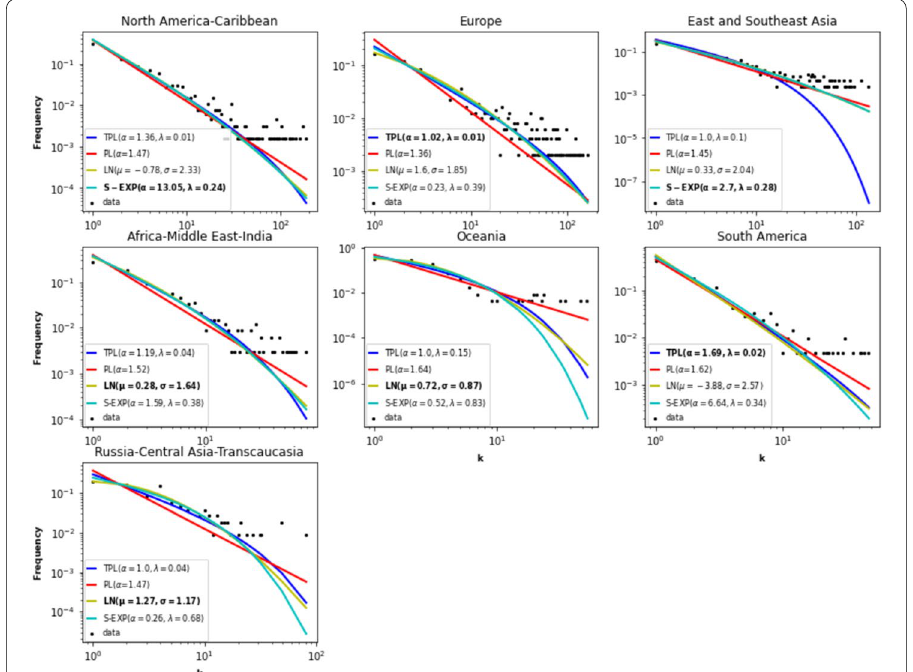
Fig. 7 Degree distributions of the large local components. Empirical distribution ( dot ), estimates ( line ). The distributions under test are: power law (PL), truncated power law (TPL), log-normal (LN) and stretched exponential (S-EXP). The values in bold are the parameters of the best fit according to the Kolmogorov– Smirnov test